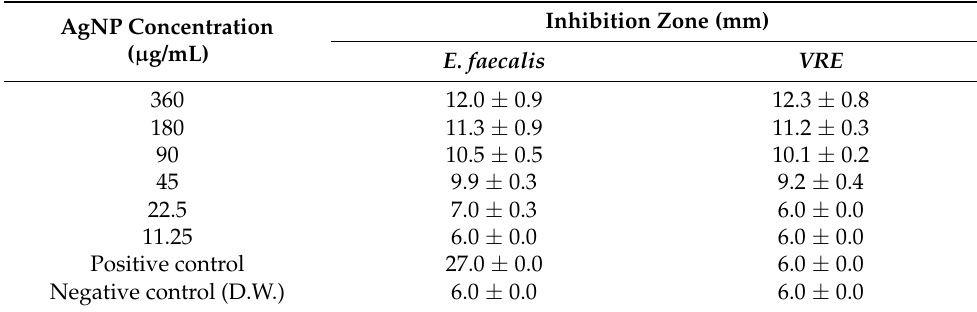
Figure 5. Antibacterial effects of AgNPs using A. catechu against E. faecalis and VRE. ( a , b ) Inhibition zone of AgNPs against E. faecalis ; ( c , d ) inhibition zone of AgNPs against VRE. The AgNP treatment concentrations were 360, 180, 90, 45, 22.5, and 11.25 µ g/mL. Table 3. Diameters of inhibition zones of AgNPs using A. catechu against E. faecalis and vancomycin- resistant Enterococcus faecalis